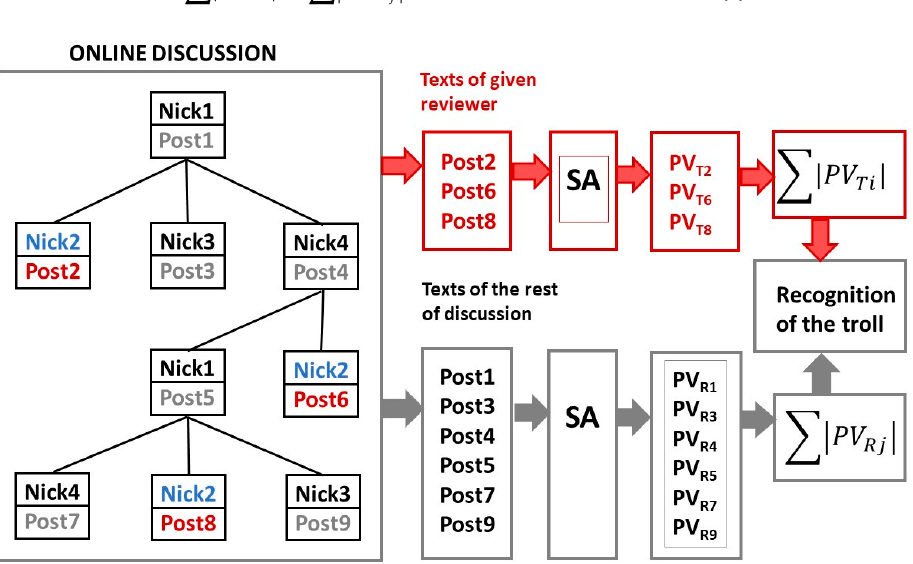
Figure 2. Illustration of the new approach to detection of the TROLL_opponent using an example with four reviewers in online discussion. The opinion polarity values of posts 2, 6 and 8 of reviewer Nick2 are compared to the opinion polarity of the other posts 1, 3, 4, 5, 7 and 9 in the online discussion. Particularly, the average absolute value of polarity of all posts of the examined reviewer is compared to the average absolute value of polarity of all rest posts of the online discussion. If the difference between them is greater than given threshold (see Equation (1)), then the examined reviewer is classified to the class TROLL_opponent.